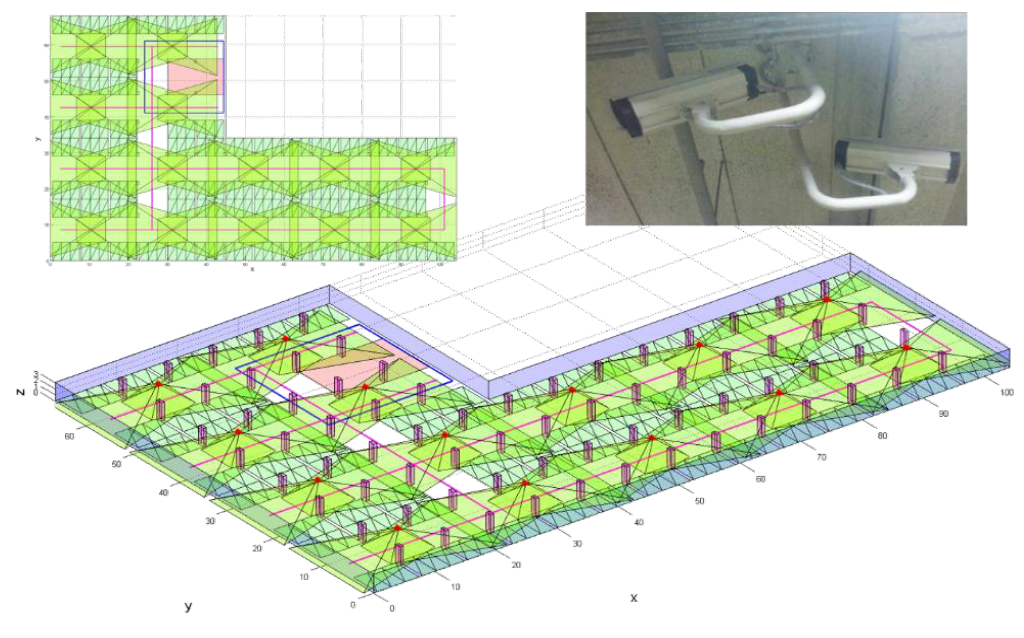
Figure 4. Arrangement of CCTV cameras in an underground parking